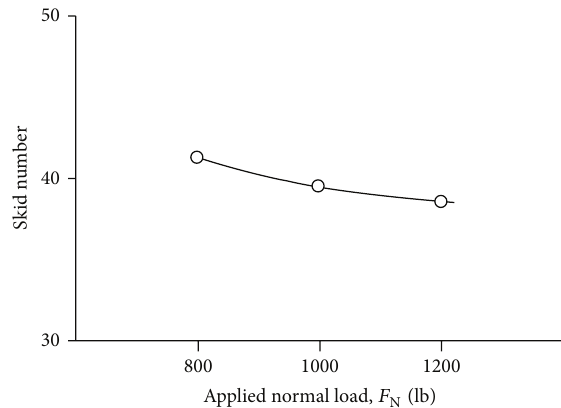
Figure 6: Transportation Research Board [4] Figure A-41 data replotted as skid number versus applied normal load ( 𝐹 N ). As shown in Figure 1, the largest friction force developed, approximately 445 lbf, corresponds to the largest applied load, 1200lb, in wet conditions.